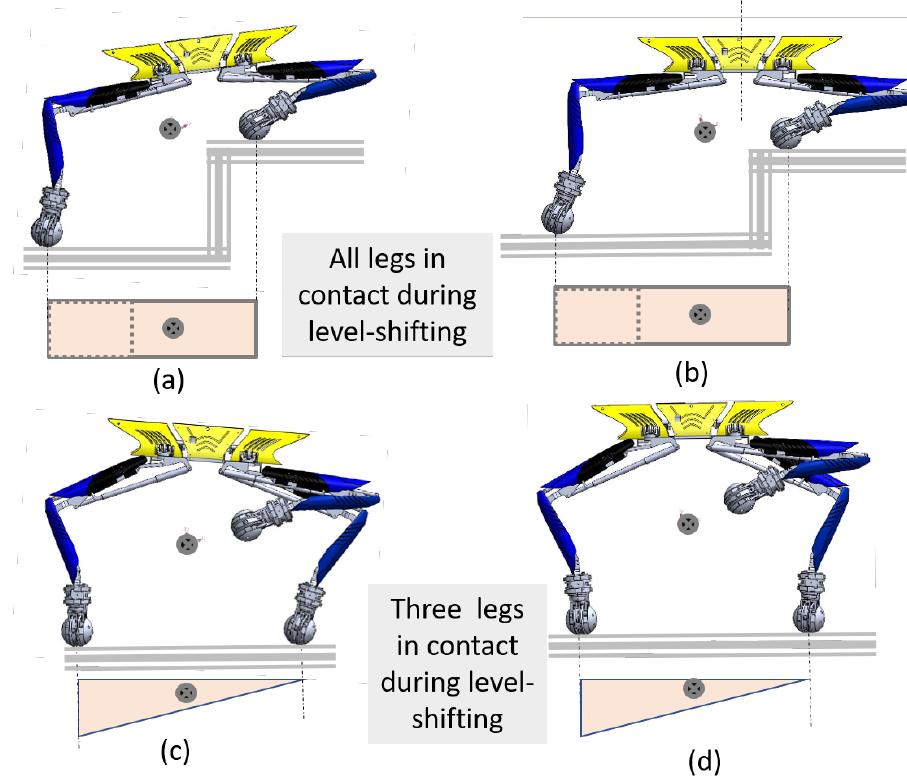
Figure 9. The variation of the CG location and the support polygon of the platform during level shifting: ( a ) all legs are in contact and the trunk is inclined, ( b ) all legs are in contact and the trunk is horizontal, ( c ) three legs are in contact and the trunk is inclined, and ( d ) three legs are in contact and the trunk is